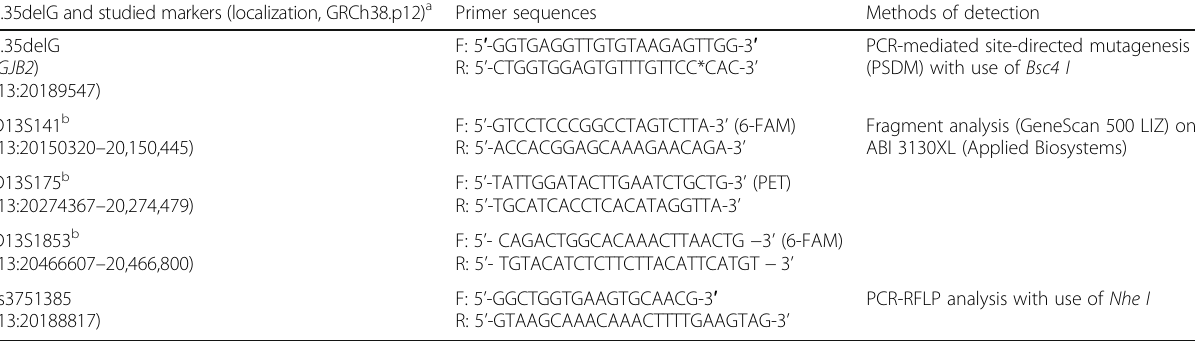
Table 1 Primer sequences for PCR, fragment analysis and Sanger sequencing c.35delG and studied markers (localization, GRCh38.p12) a Primer